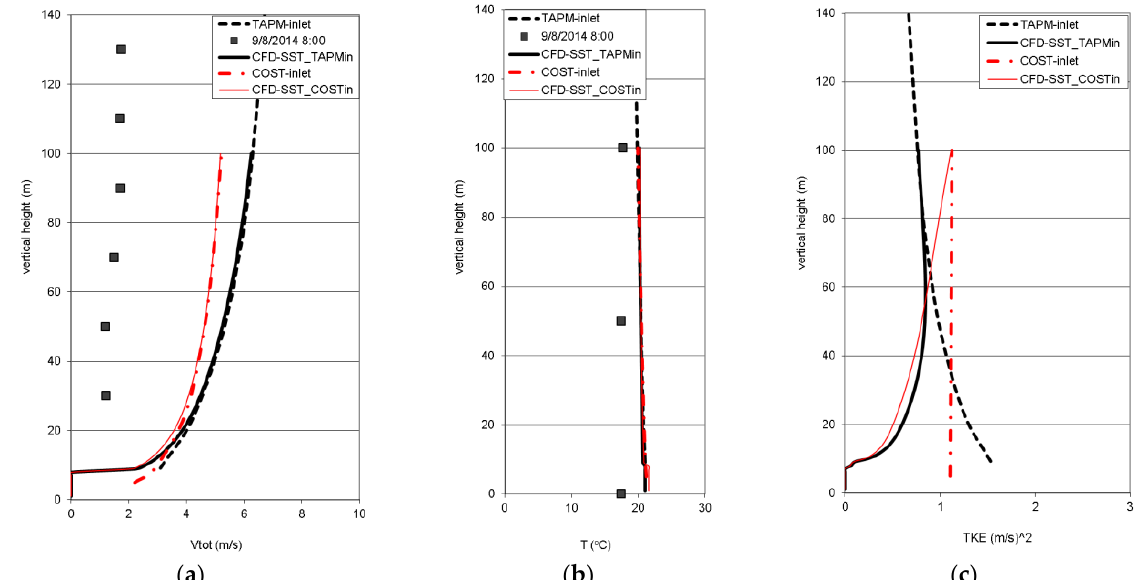
Figure 10. ( a ) Vertical profiles of wind speed and ( c ) wind turbulence kinetic energy over position 2 and ( b ) air temperature over position 1 (Figure 1). CFD results, neutral atmosphere (C in Table 1), SST turbulence model and inlet profiles from mesoscale results (“TAPM-inlet”) and from the COST 710 recommendations (“COST-inlet”).